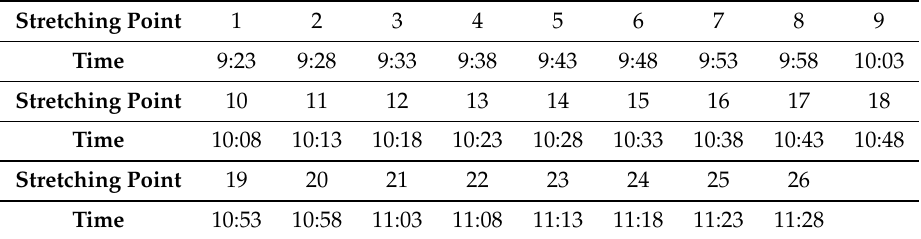
Table 1. Stretch times of individual protective fence points.